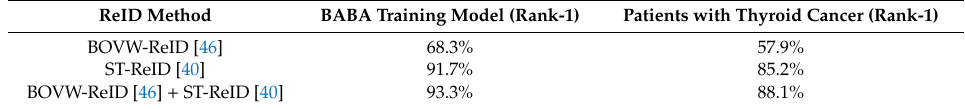
Table 2. Comparative performance of re-identification methods.